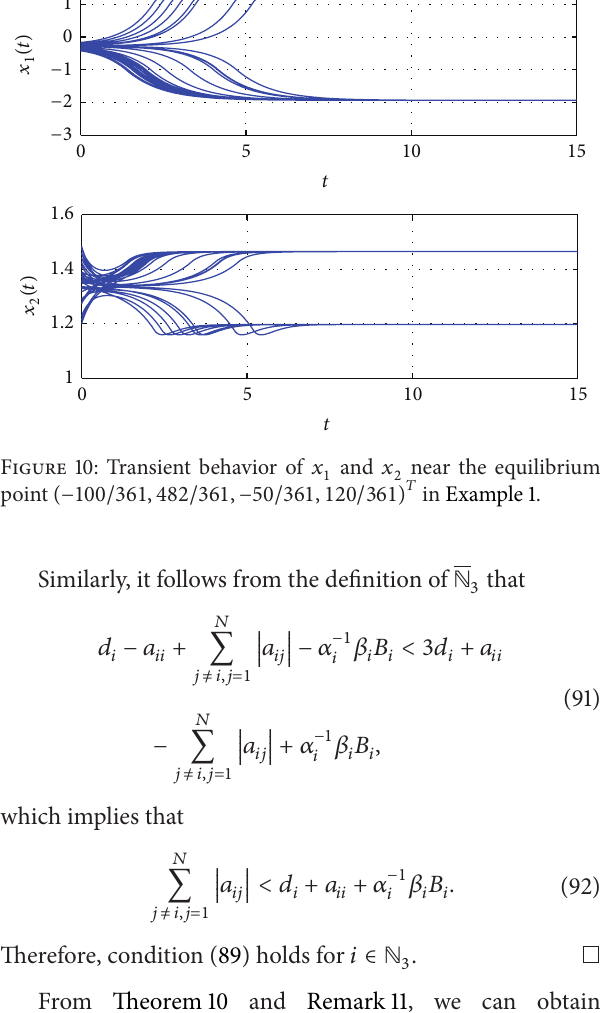
Figure 13: Transient behavior of 𝑥 2 in Example